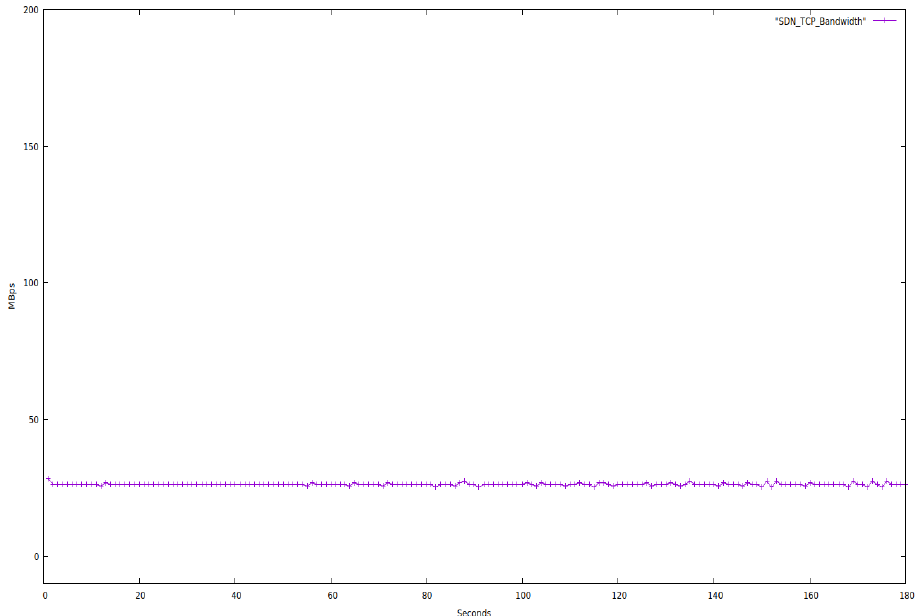
Figure 6. SDN TCP Bandwidth Fluctuation.